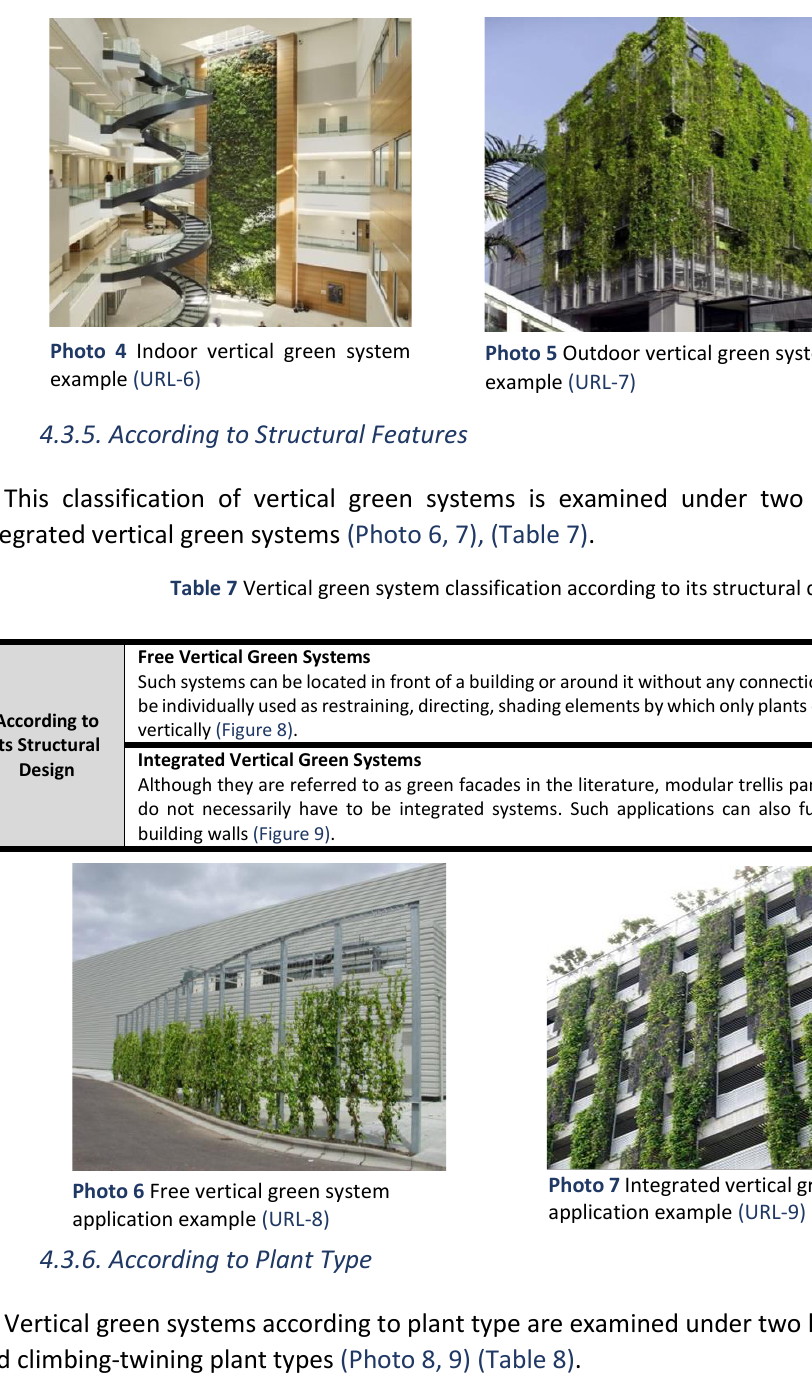
Table 8 Vertical green system classification according to plant